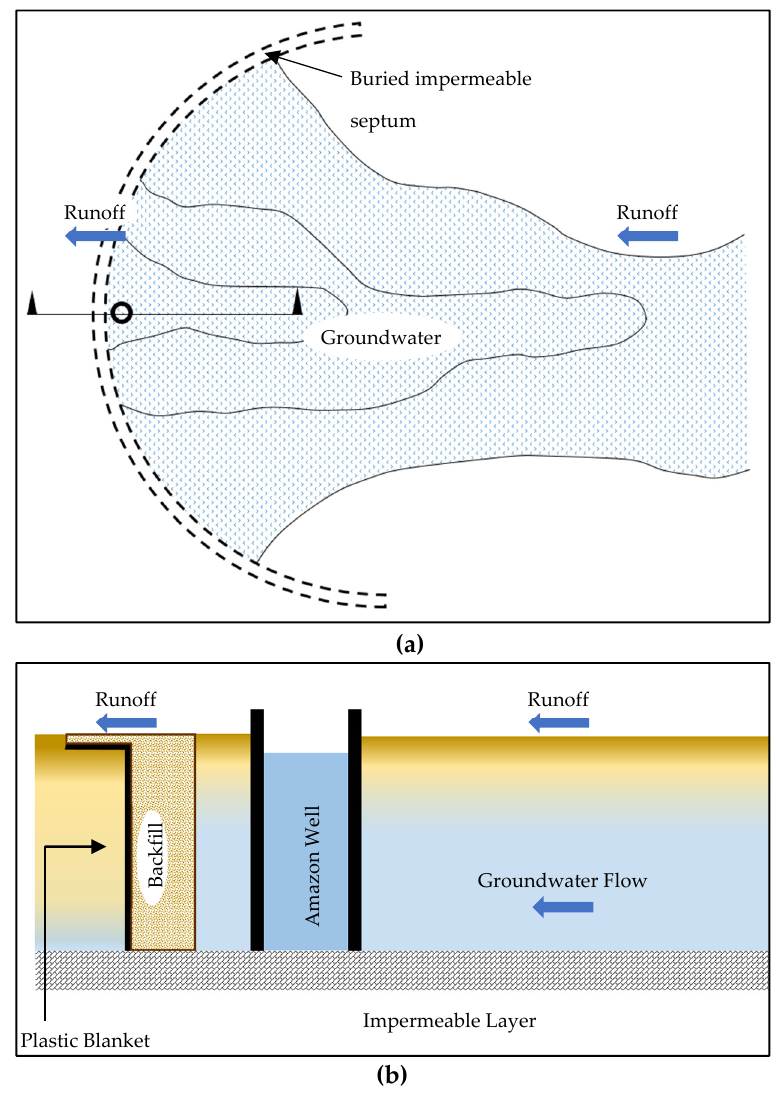
Figure 4. Costa & Mello type underground dam—submerged dam ( a ) Ground plan; ( b ) Cross section.